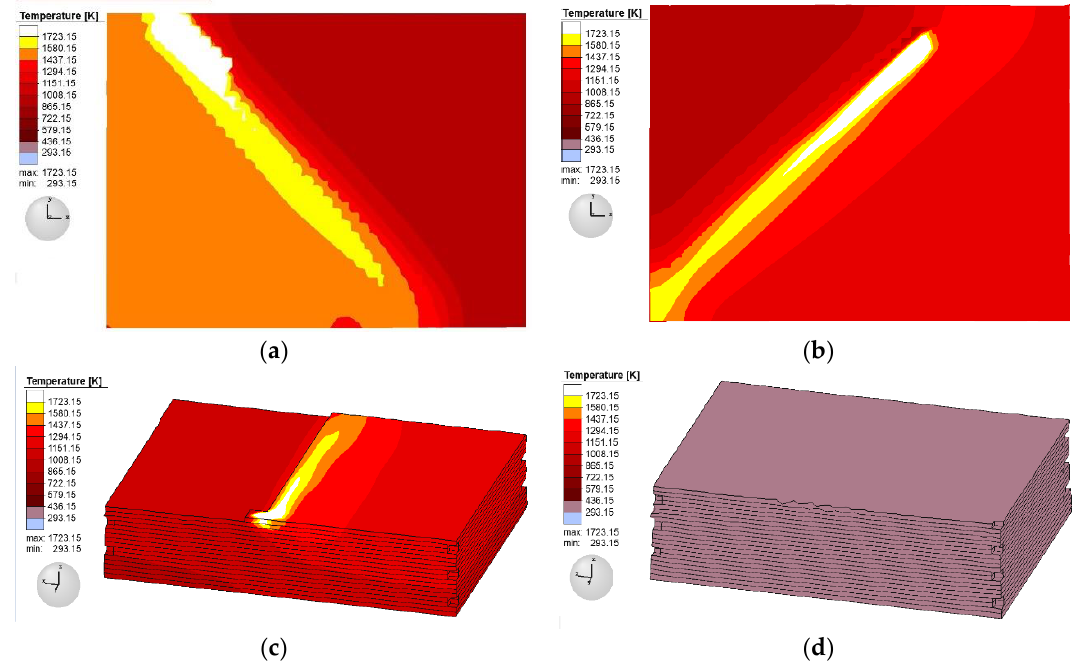
Figure 7. Thermal field distribution at different positions in the simulation at ( a ) 10 layers; ( b ) 20 layers; ( c ) 38 layers; and ( d ) 40 layers.